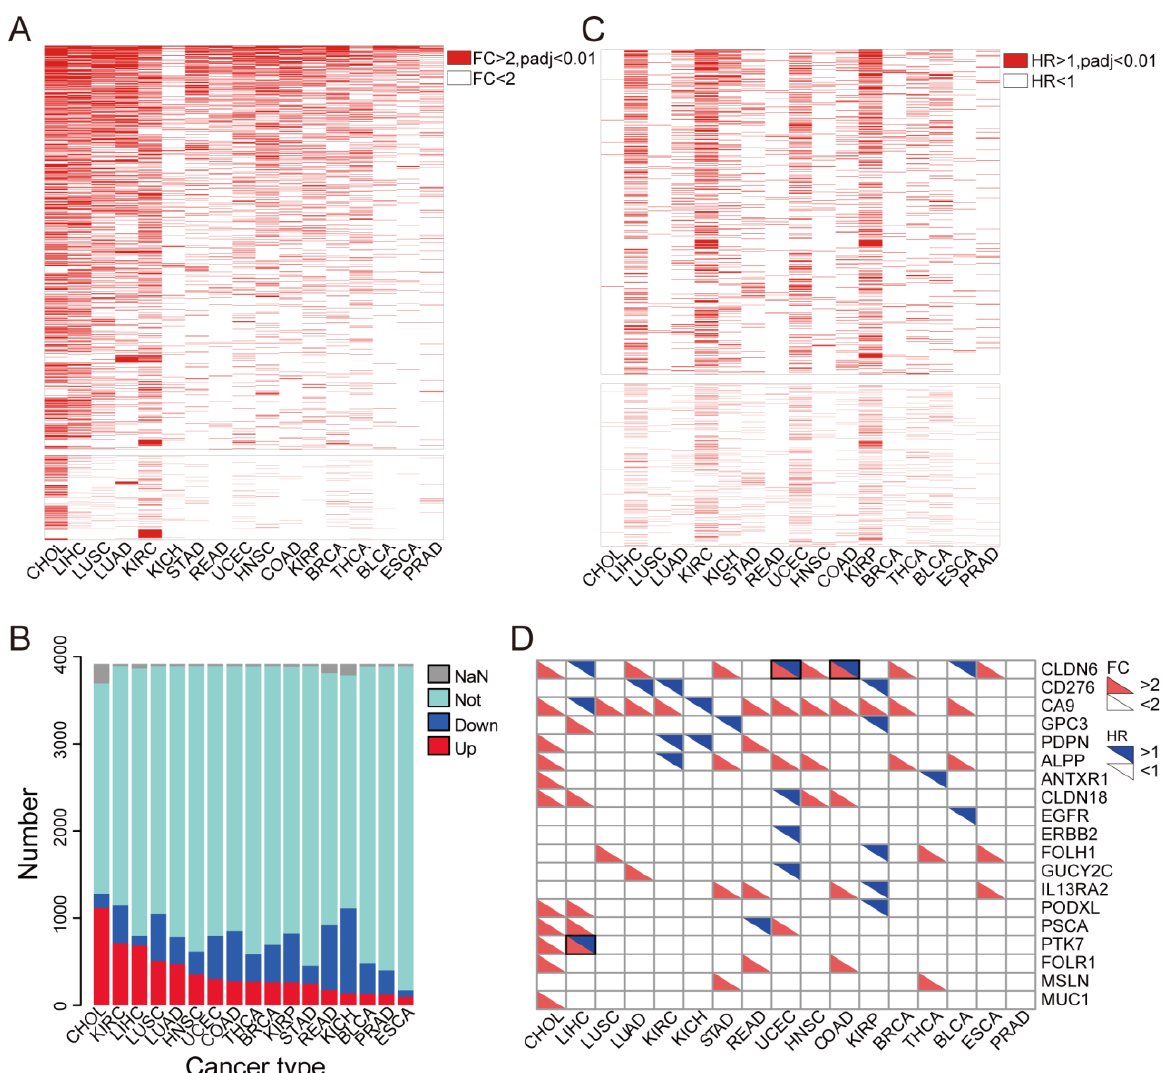
Figure 2. Tumor-specific high-expression and high-risk surface proteins in TCGA tumor tissues. ( A ) Heatmap plot displays the differential expression analysis of the tumor tissue-specific highly expressed membrane proteins. A FC > 2, and the adjusted p value less than 0.01 is considered statistically significant. ( B ) Membrane proteins displayed poor prognosis in cancer patients. A HR > 1, and the adjusted p value less than 0.01 was considered statistically significant. ( C ) Stacked bar blot showed the categories of 3919 membrane proteins: up-regulation (up), down-regulation (down), no change significance (not), and missing data (NaN). ( D ) The color block diagram shows the FC and HR of the target proteins, all colored squares are statistically significant.